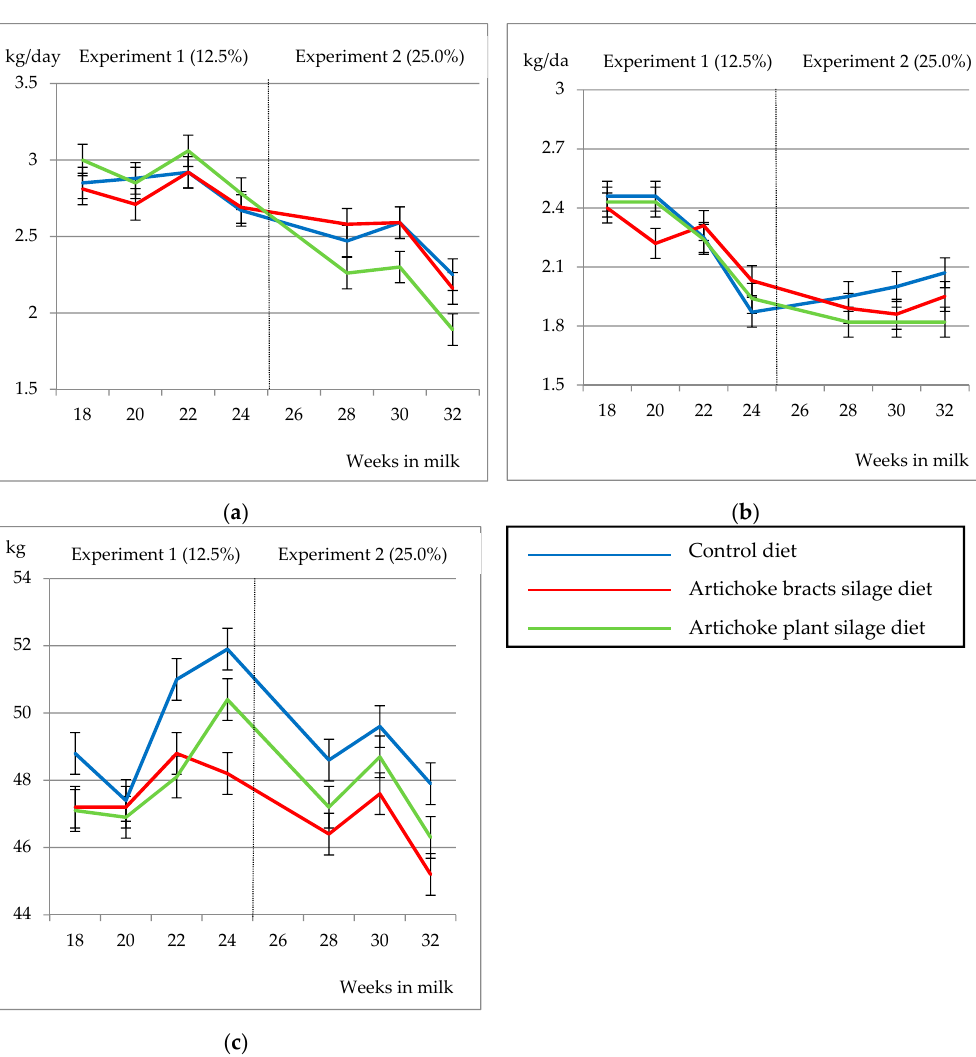
Figure 1. Changes in milk yield ( a ), fat corrected milk ( b ) and average body weight ( c ) due to diet throughout the lactation in experiments 1 and 2.